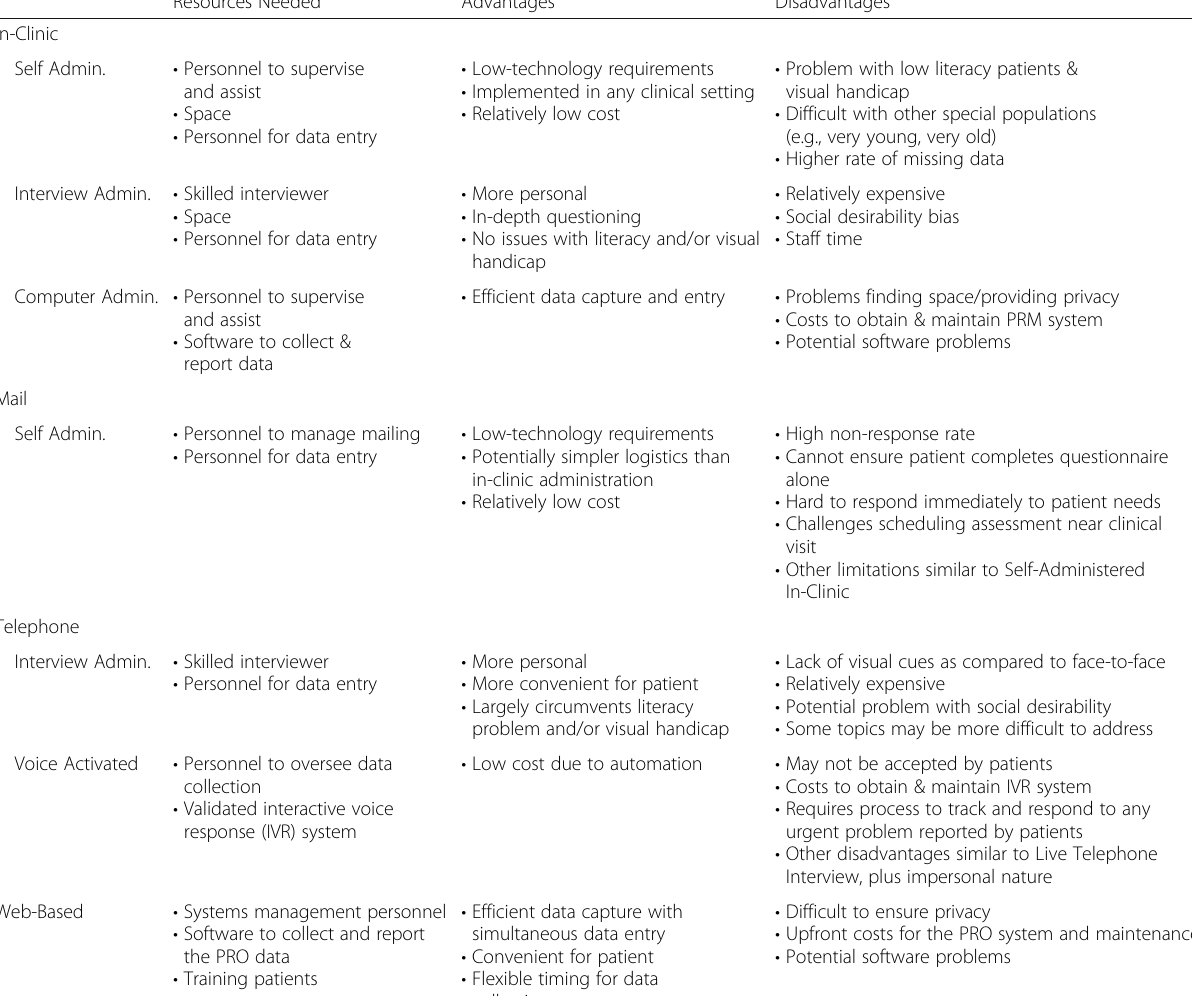
Table 2 International Society for Quality of Life Research Summary of Mode of Administration for PRMs Resources Needed Advantages